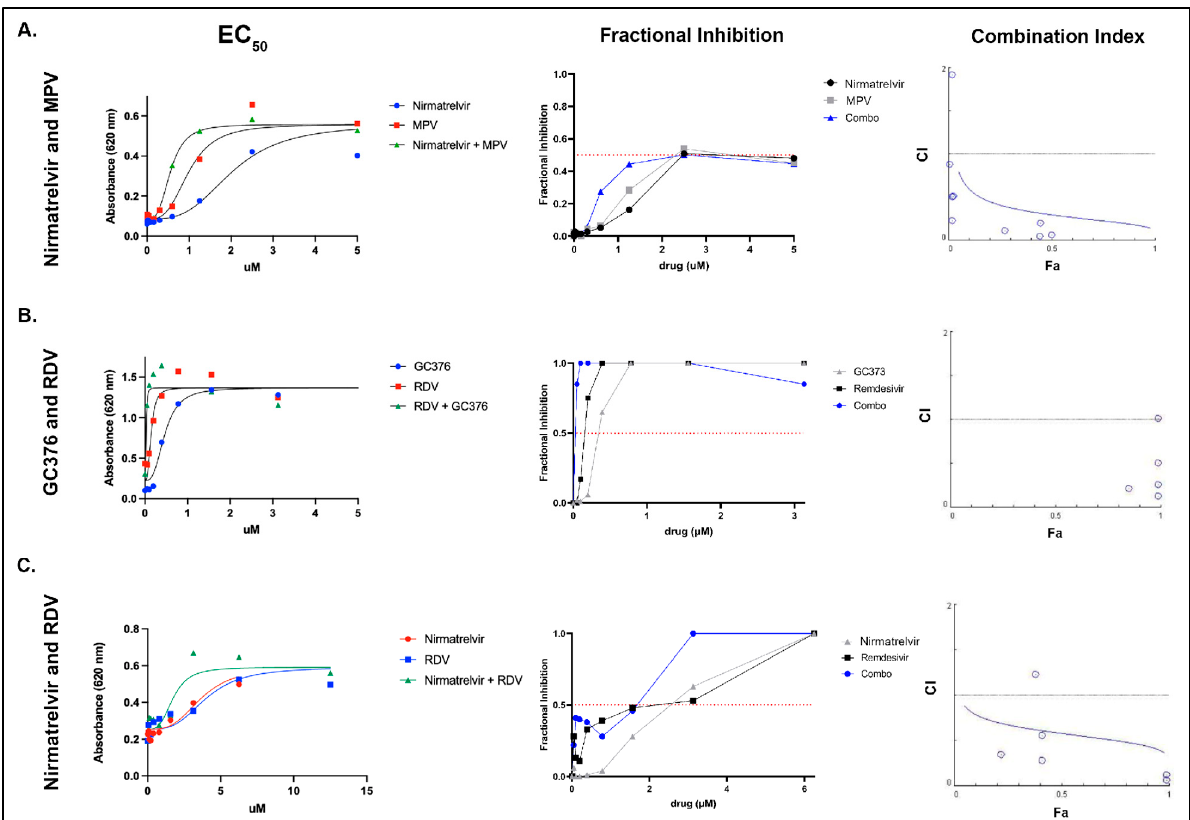
Figure 2. EC50, fractional inhibition values, and isobologram plots (combination index) representing the three evaluated compound combinations. Left column visually demonstrating individual nonlinear regression curves overlain with combination nonlinear regression curves for the three listed combinations. EC 50 values: ( A ) Nirmatrelvir alone—1.313 μ M, MPV alone—0.693 μ M, nirmatrelvir combined with MPV—0.5640 μ M. ( B ) GC376 alone—0.406 μ M, remdesivir alone—0.181 μ M, GC376 combined with remdesivir—0.046 μ M. ( C ) remdesivir alone—6.416 μ M, nirmatrelvir alone—2.936 μ M, and RDV combined with nirmatrelvir—1.670 μ M. The middle column shows fractional inhibition curves demonstrating the increased fractional inhibition for antiviral combinations at the corresponding drug concentrations. The right column includes isobologram plots that illustrate CI values generally below 1 for all three antiviral compounds, consistent with compound synergy (hor- izontal line). Fraction affected (Fa) shown on x axis.